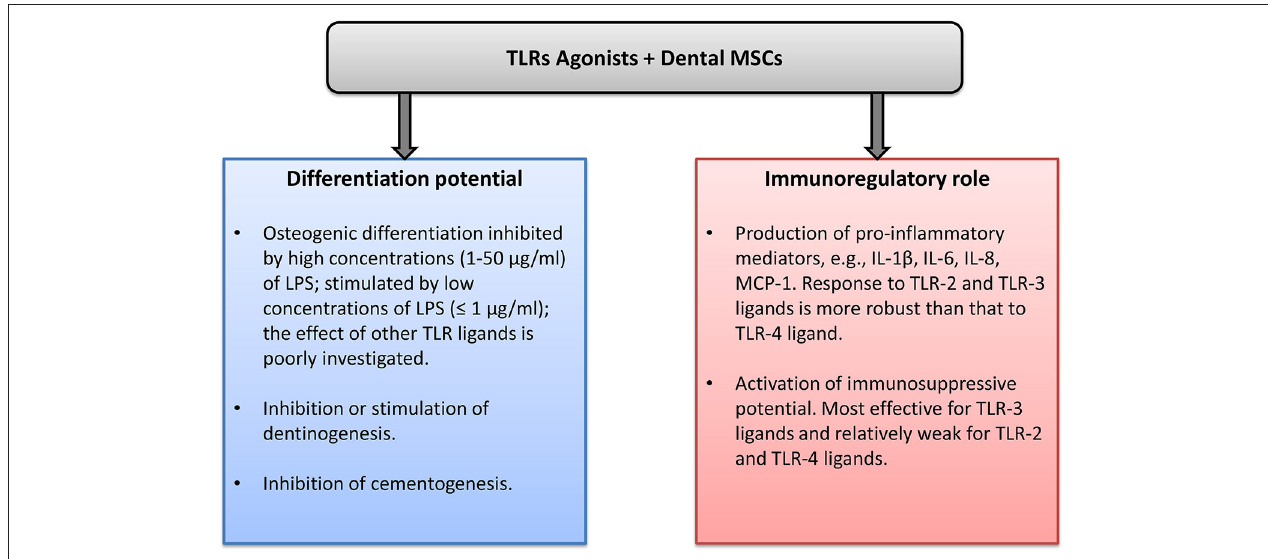
FIGURE 1 | Effects of toll-like receptor (TLR) agonists in dental mesenchymal stromal cells